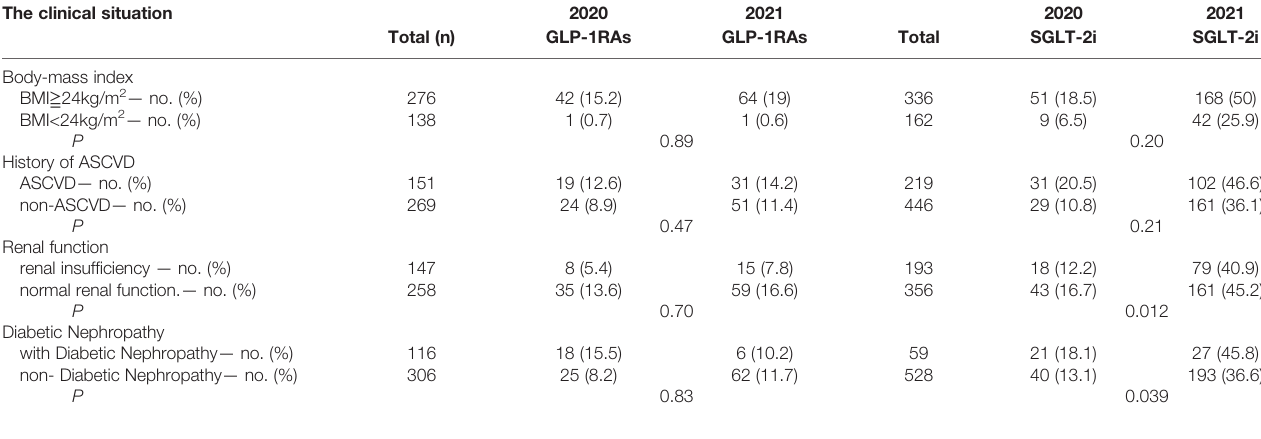
TABLE 4 | Application rates of GLP-1 RAs/SGLT-2i of inpatients with type 2 diabetes in different clinical situations. The clinical